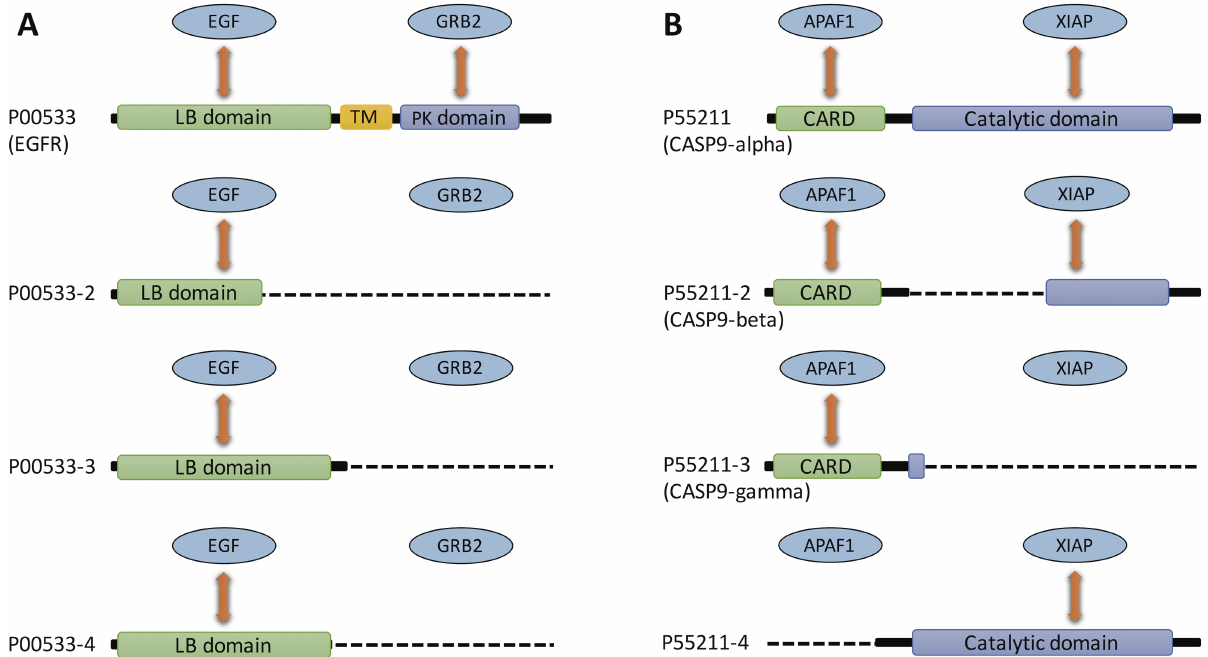
Fig 5. Case studies of protein pairs interacting with different subsets of isoforms of the same gene. (A) Two proteins (EGF and GRB2) interactingwith different subsets of isoforms of EGFR. EGF interacts with all four isoforms of EGFR on their ligand-binding domain, whereasGRB2 interacts only with the first isoform (P00533)and does not interact with any of the other three isoforms (P00533-2, P00533-3 and P00533-4)that lack the protein kinase domain. (B) Two proteins (XIAP and APAF1) interactingwith different subsets of isoforms of CASP9. APAF1 interacts with three isoforms of CASP9 (P55211,P55211-2and P55211-3)on their CARD domainand loses interactionwith the fourth isoform P55211-4.XIAP interacts with three isoforms of CASP9 (P55211,P55211-2and P55211-4) on their catalytic domainand has no experimentally confirmedinteraction with the third isoform